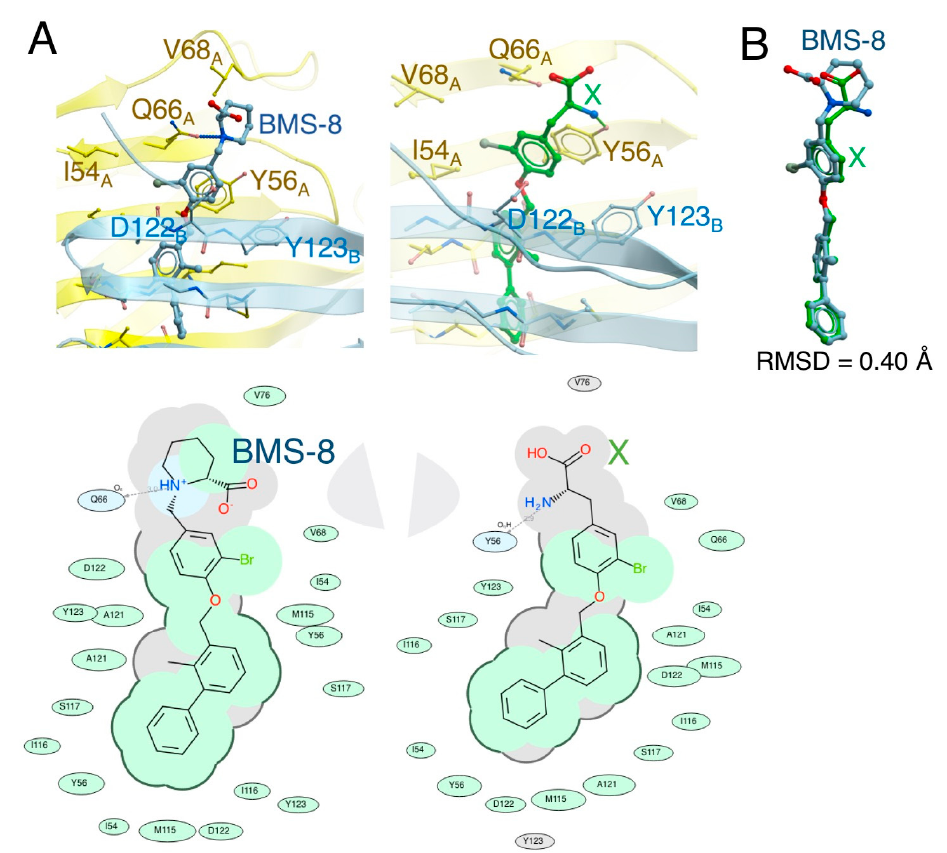
Figure 6. Docking conformations of BMS-8 and X . ( A ) The docking modes of BMS-8 and X were revealed by the X-ray crystallography and in silico docking simulation, respectively, which the 2D binding pictures. The 2D figures show that biphenyl portions of the ligands bind into the pocket by hydrophobic interactions shown in light-green color. In contrast, the amino cation at the six-membered ring of BMS-8 makes a hydrogen bond with the sidechain of Q66 A in cyan color. In addition, the six-membered ring makes hydrophobic interaction with V68 A . On the other hand, amino-group of bromo-tyrosine in X makes a hydrogen bonding to the hydroxyl group of Y56 A colored in cyan, without other hydrophobic interaction, as shown in the 2D picture. ( B ) BMS-8 and X without C α , NH 2 , and COOH superposed each other with RMSD of 0.40